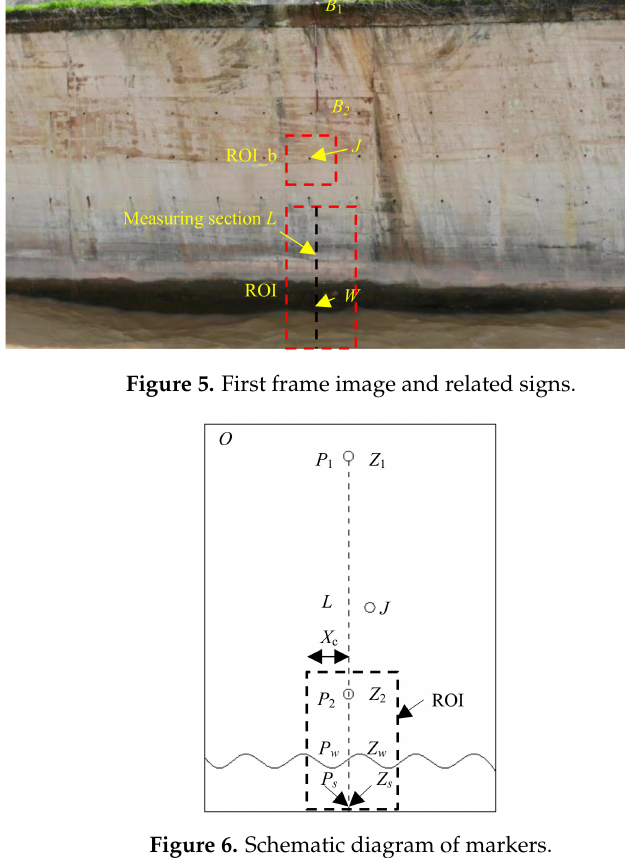
Figure 6. Schematic diagram of